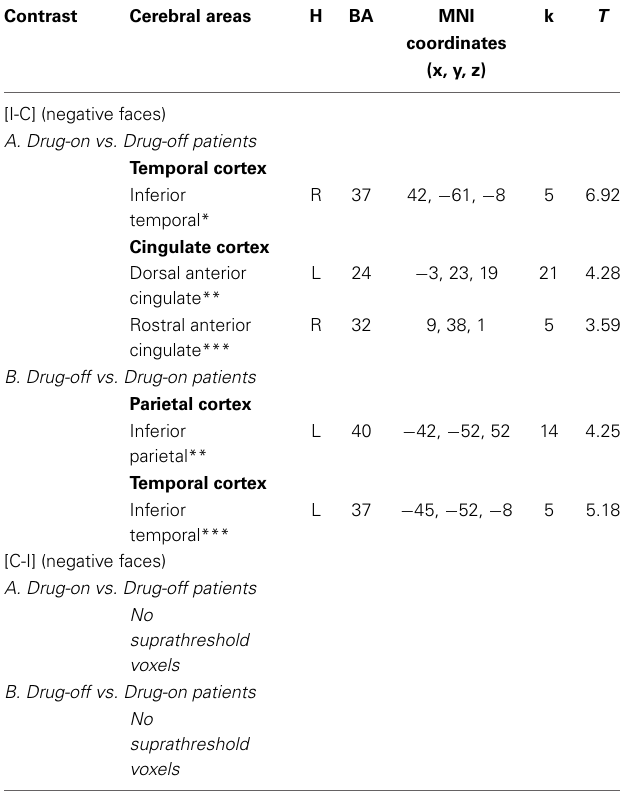
Table 9 | Comparisons between drug-on and drug-off patients: cerebral sites of hemodynamic response during the emotional Stroop task with negative